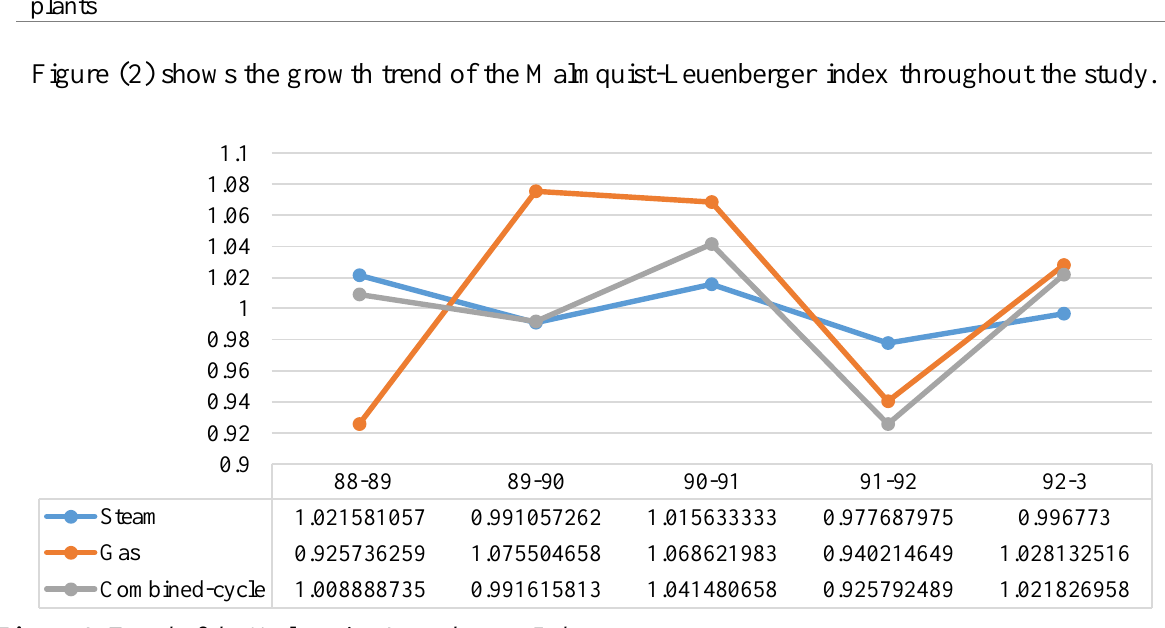
Table 5. The Malmquist-Leuenberger Index in Iranian thermal power plants